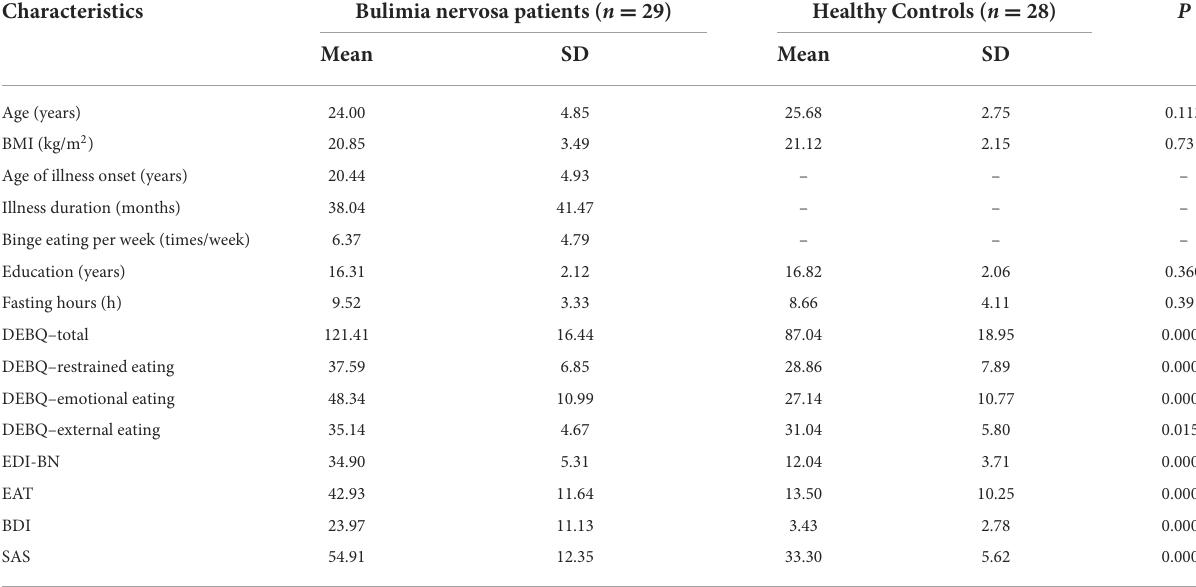
TABLE 1 Baseline demographics and clinical characteristics of participants.